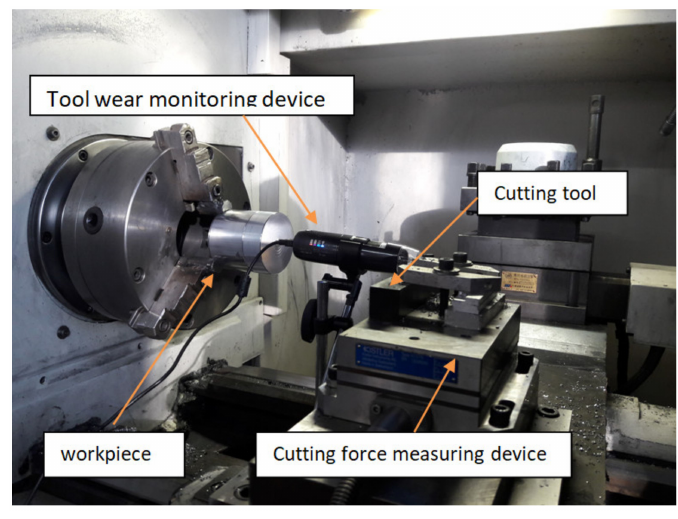
Figure 1. Experimental setup. Table 1. Cutting Parameters for Cutting Force SiCp / Al 45